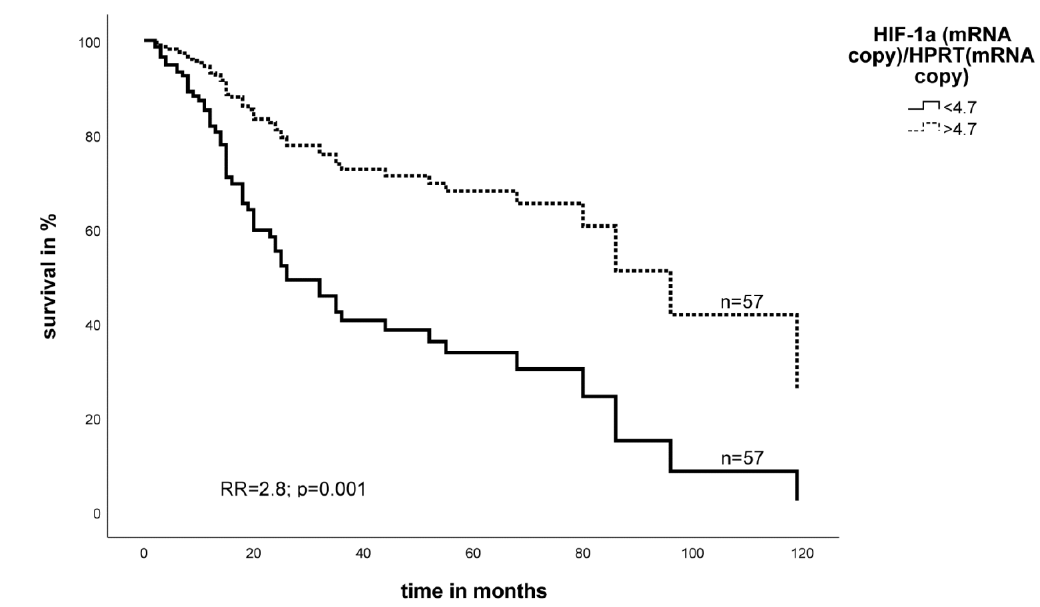
Figure 1. Multivariate Cox’s hazard regression model for HIF-1 α mRNA expression and tumor-specific survival in STS patients. The expression of HIF-1 α mRNA for 114 STS patients was associated with survival. The model was adjusted for tumor stage, tumor localization, tumor entity, and the type of tumor resection. The high and low cut-off values for HIF-1 α were >4.7 and ≤ 4.7 copies of HIF-1 α mRNA relative to the number of copies of hypoxanthine phosphoribosyltransferase (HPRT) mRNA, respectively (relative risk (RR) = 2.8, p = 0.001).